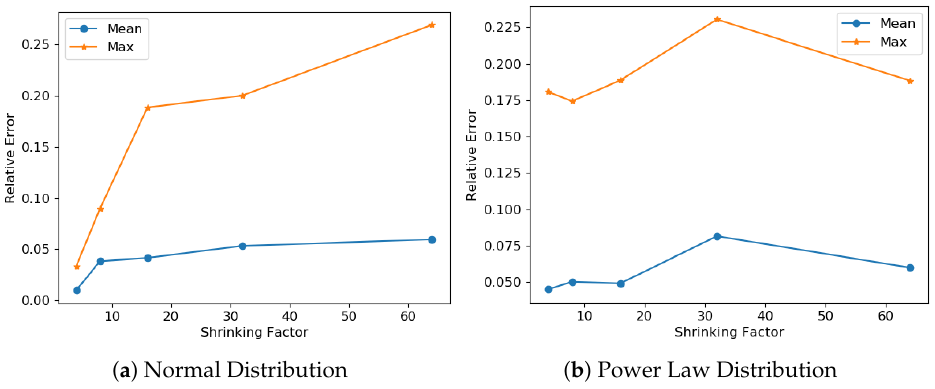
Figure 7. How accuracy changes with shrinking factor for normal and power law distribution